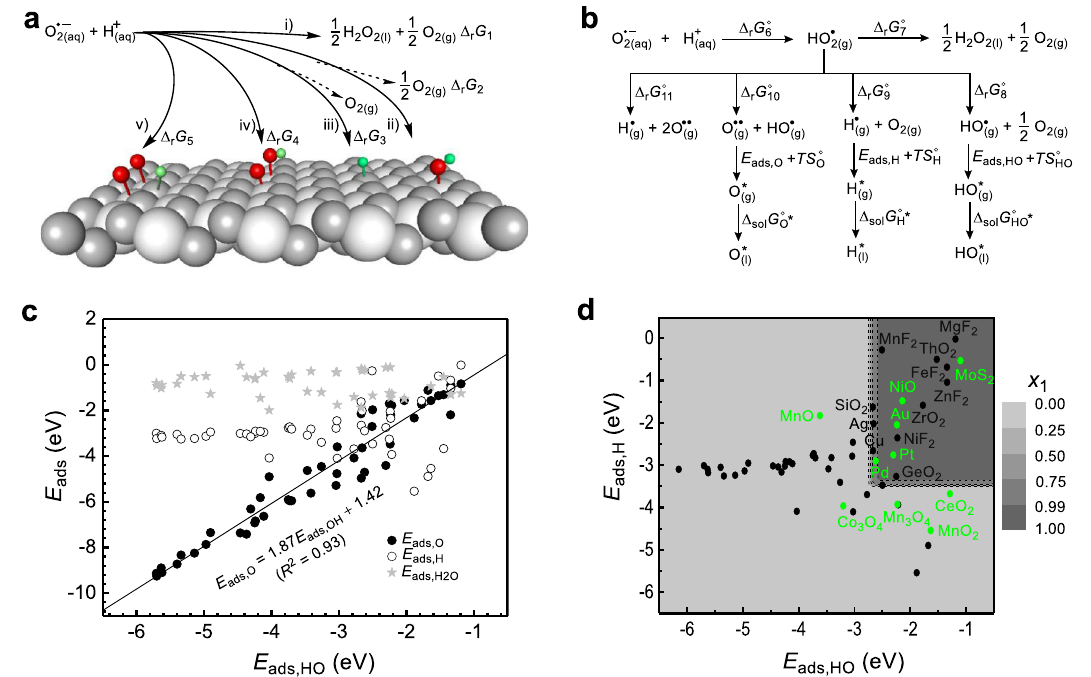
Fig. 3 The adsorption energy principle for NMs to catalytically scavenge O 2 (cid:129) − . a The dismutation (i) and competitive side reactions (ii − v) of O 2 (cid:129) − that may occur on the surface of nanomaterials. b The Hess cycles for reactions (i − v). c The adsorption energies of O (cid:129)(cid:129) , H (cid:129) , and H 2 O with respect to that of HO (cid:129) on various material surfaces. d The contour plot of the partition function x 1 as a function of E ads,HO and E ads,H . In a , O and H are shown in red and green, respectively; the other atoms are of the substrate. In d , the fi lled green and black circles represent nanomaterials whose superoxide dismutase-like activities have and have not been experimentally